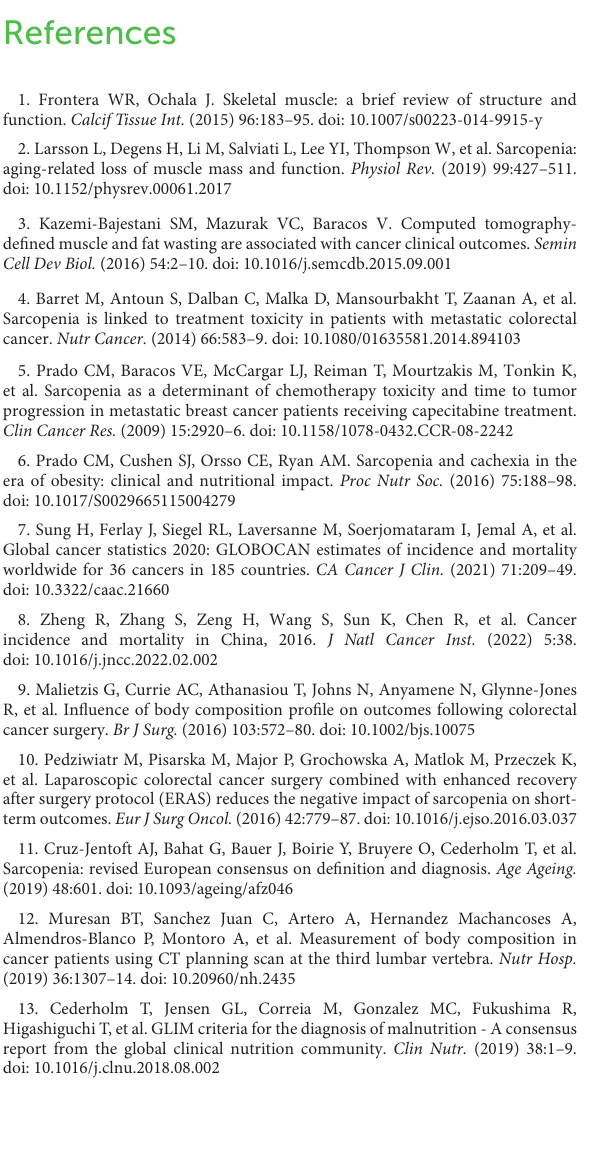
SUPPLEMENTARYTABLE1 Assessment of muscle